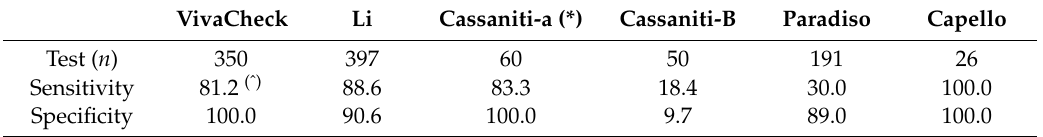
Table 1. Colloidal gold rapid test sensitivity and specificity versus real-time polymerase chain reaction (RT-PCR) in di ff erent experimental settings (VivaChek, Cassaniti-a, Capello: Volunteers, healthcare workers, and patients; Li, Cassaniti-b, Paradiso: Patients tested in specific